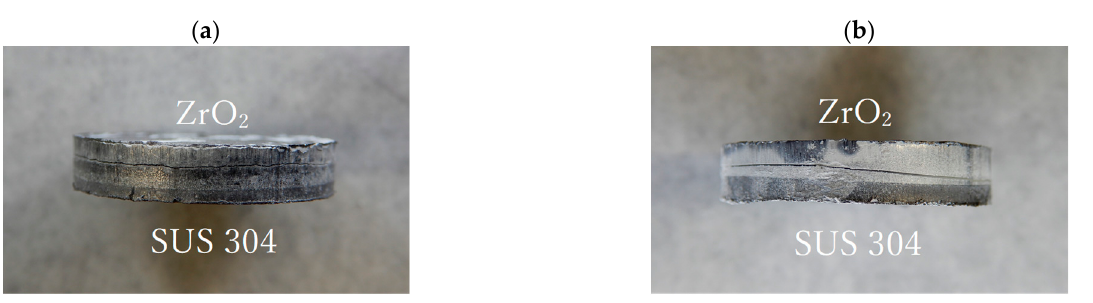
Figure 15. ZrO 2 -rich surfaces of the FGMs subject to cyclic thermal shock loadings.